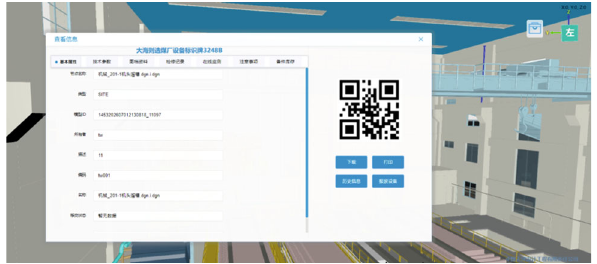
Figure 8: QR code management for equipment of Wangjialing Coal Preparation Plant.